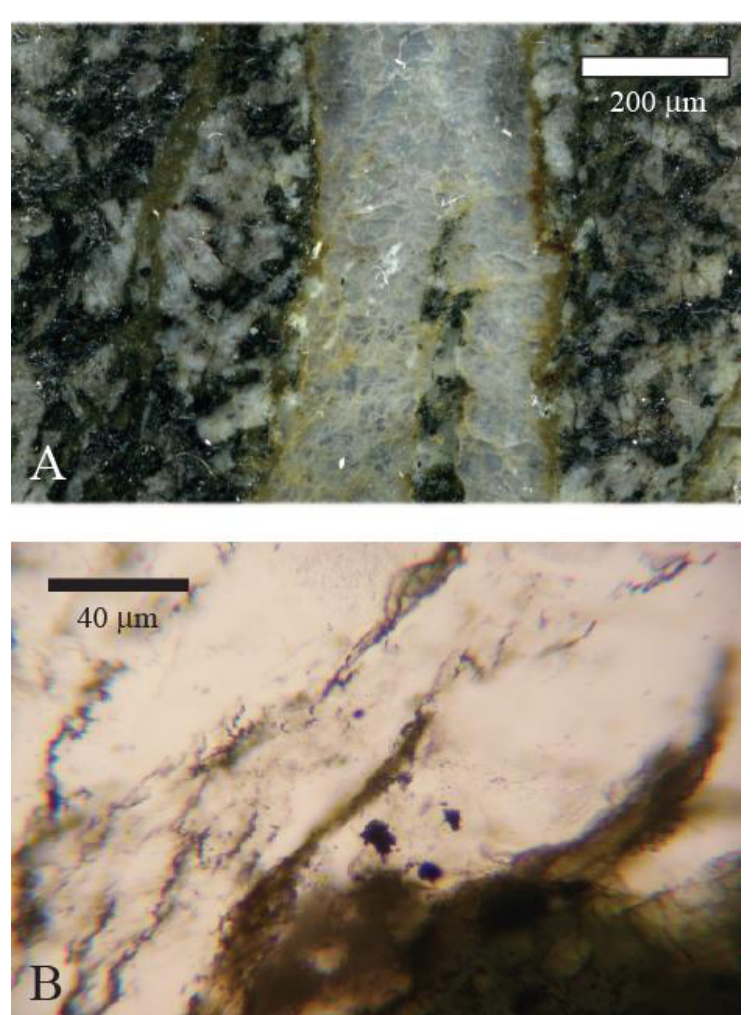
Figure 6. ( A ) Amphibole along vein contacts in quartz and ( B ) an illustration of a schlieren-like appearance of